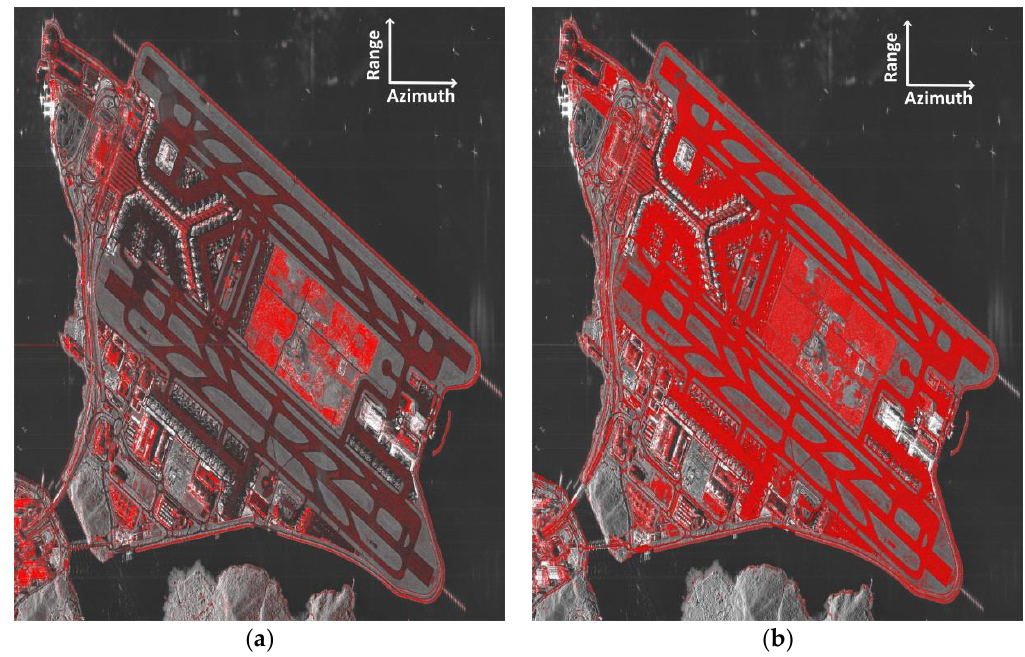
Figure 5. The MPs identified using PSI method ( a ) and proposed DSI strategy ( b ) at HKIA.